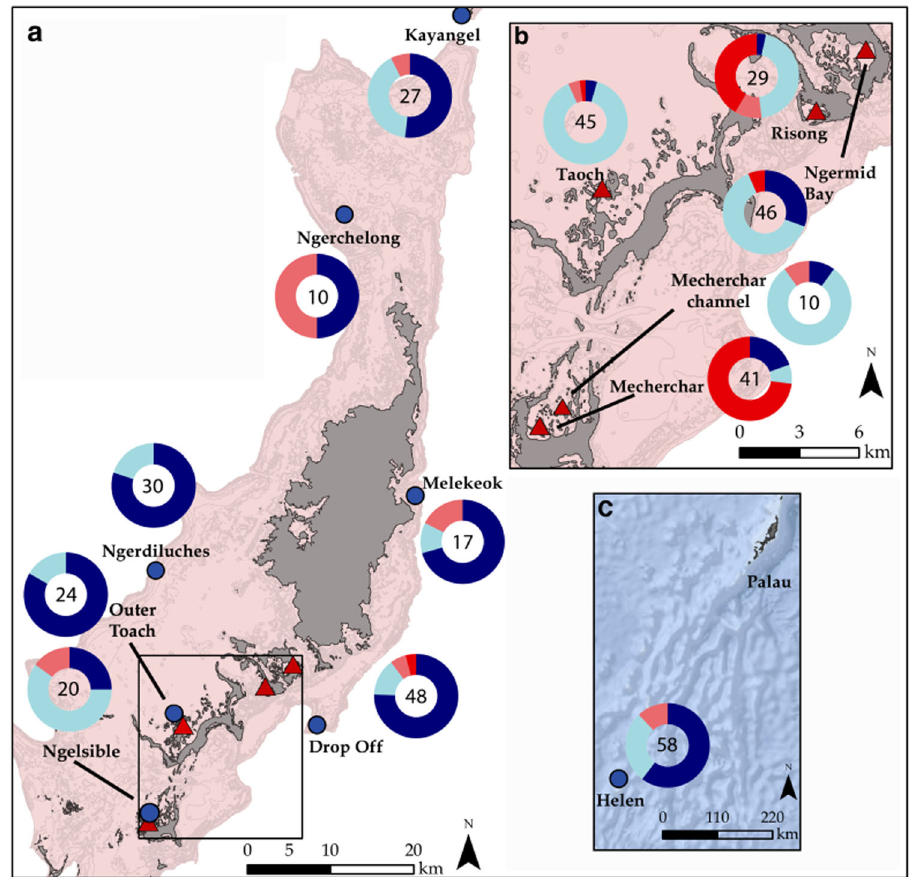
Fig. 2 Distribution of Porites cf. lobata lineages across sampling sites. Land is denoted in gray and the reef platform in light pink. Outer reef sites are denoted by blue circles, while Rock Island sites are denoted by red triangles. Donut charts show the distribution of lineages among samples from each site where coral lineages are color coded Dark Blue (DB), Light Blue (LB), Pink (PI), and Red (RD) for visualization. Charts include both RAD-seq and microsatellite data. (For samples with both types of data, RAD-seq derived lineages were used as these predominantly agreed with microsatellite results, see Methods section and Fig. S2). Total N for each site is shown in the center of each donut chart. a Palauan mainland. b Inset showing Rock Island sites. c Palau and Helen atoll (Palau ’ s southernmost territory). Reef line shape fi les were accessed from the NOAA National Centers for Coastal Ocean